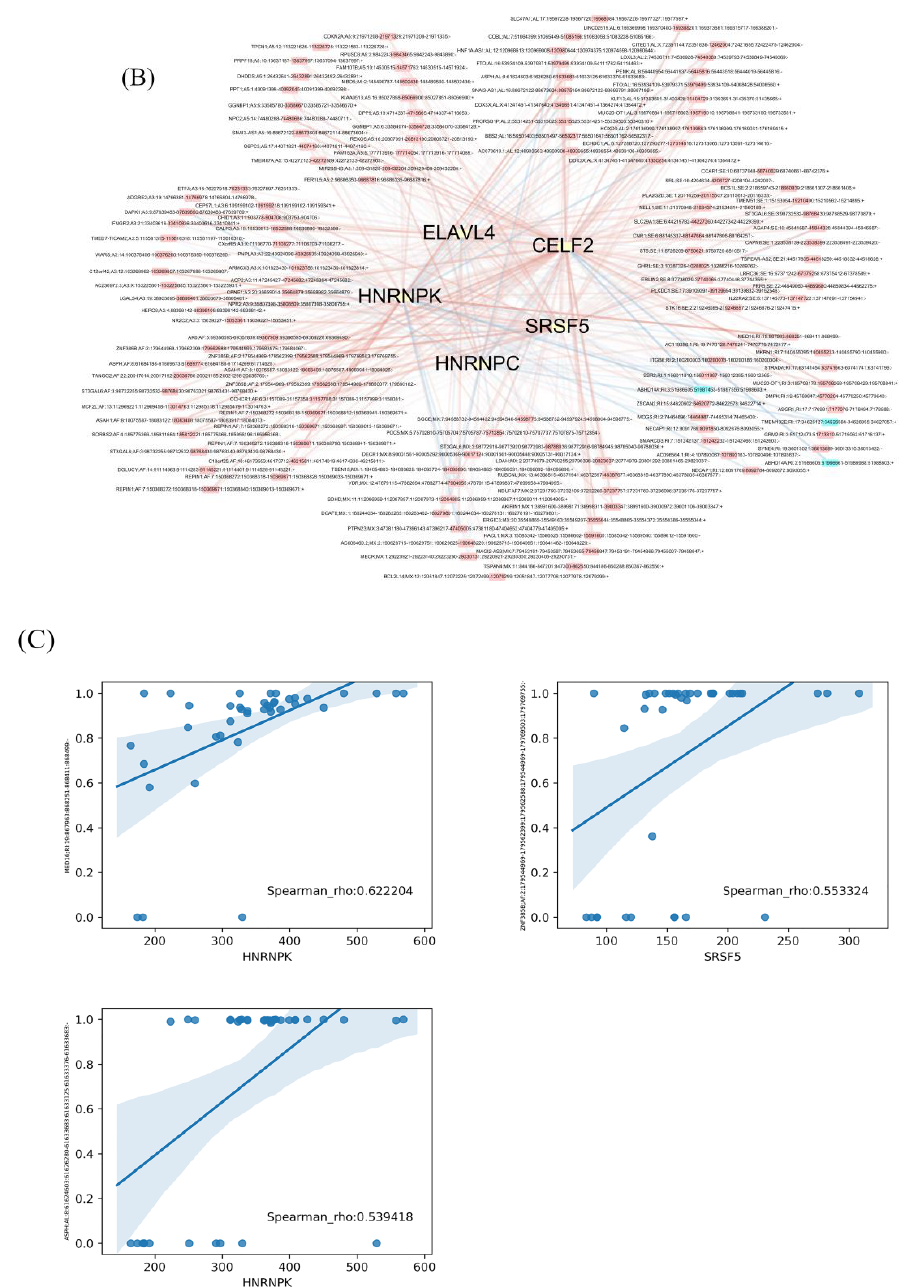
Figure 6. The correlation network of splicing factors (SFs) and the top 20 OS-related RI, SE, A5, A3, AF, AL and MX events in our LUAD cohort. ( A ) Kaplan–Meier curves of the CELF2 , SRSF5 , HNRNPK , ELAVL4 and HNRNPC SFs. Blue line indicates the high-expression group; red line indicates the low-expression group (based on median values). ( B ) AS correlation network constructed using Cytoscape. Five OS-related SFs were positively (red lines) or negatively (blue lines) associated with AS events. Red and blue dots indicate favorable and adverse AS events, respectively. A circle represents one type of AS. ( C ) Correlation analysis between the expression of HNRNPK and the RI PSI values of MED16 , between the expression of SRSF5 and the AF PSI values of ZNF385B and between the expression of HNRNPK and the AL PSI values of ASPH . blue line: regression line; blue shaded part; confidence interval for the regression estimate; blue circle: